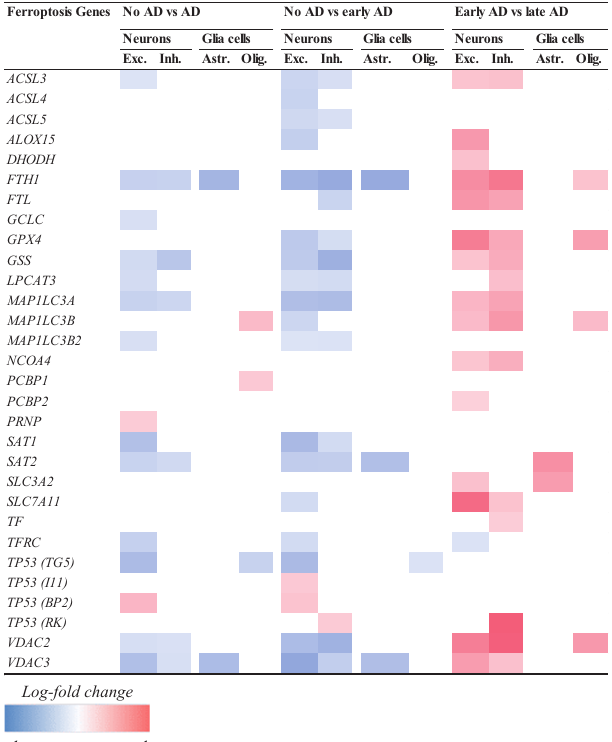
TABLE 1 | Log2-fold change of ferroptosis-related DEGs related to